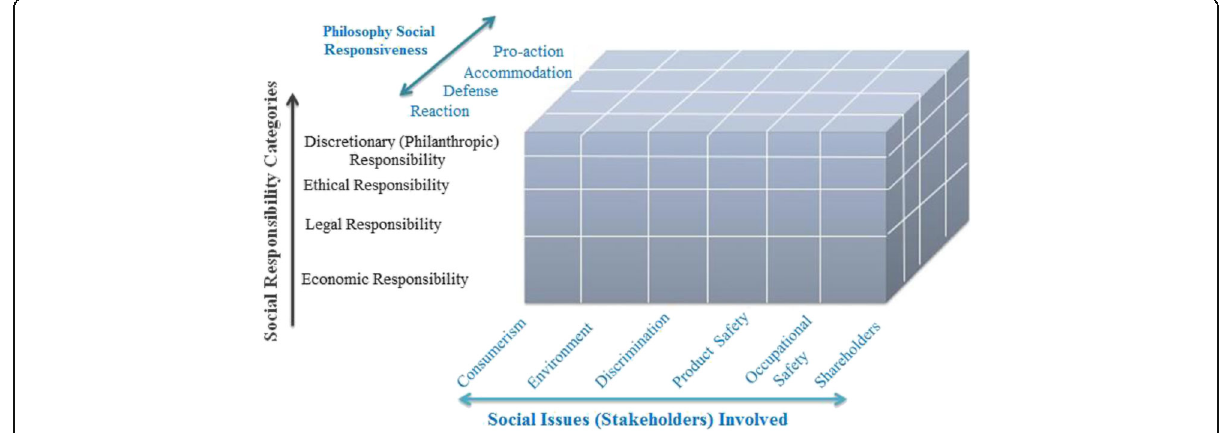
Fig. 2 Carroll ’ s Three-Dimensional Conceptual Model of Corporate Performance. Source: Carroll